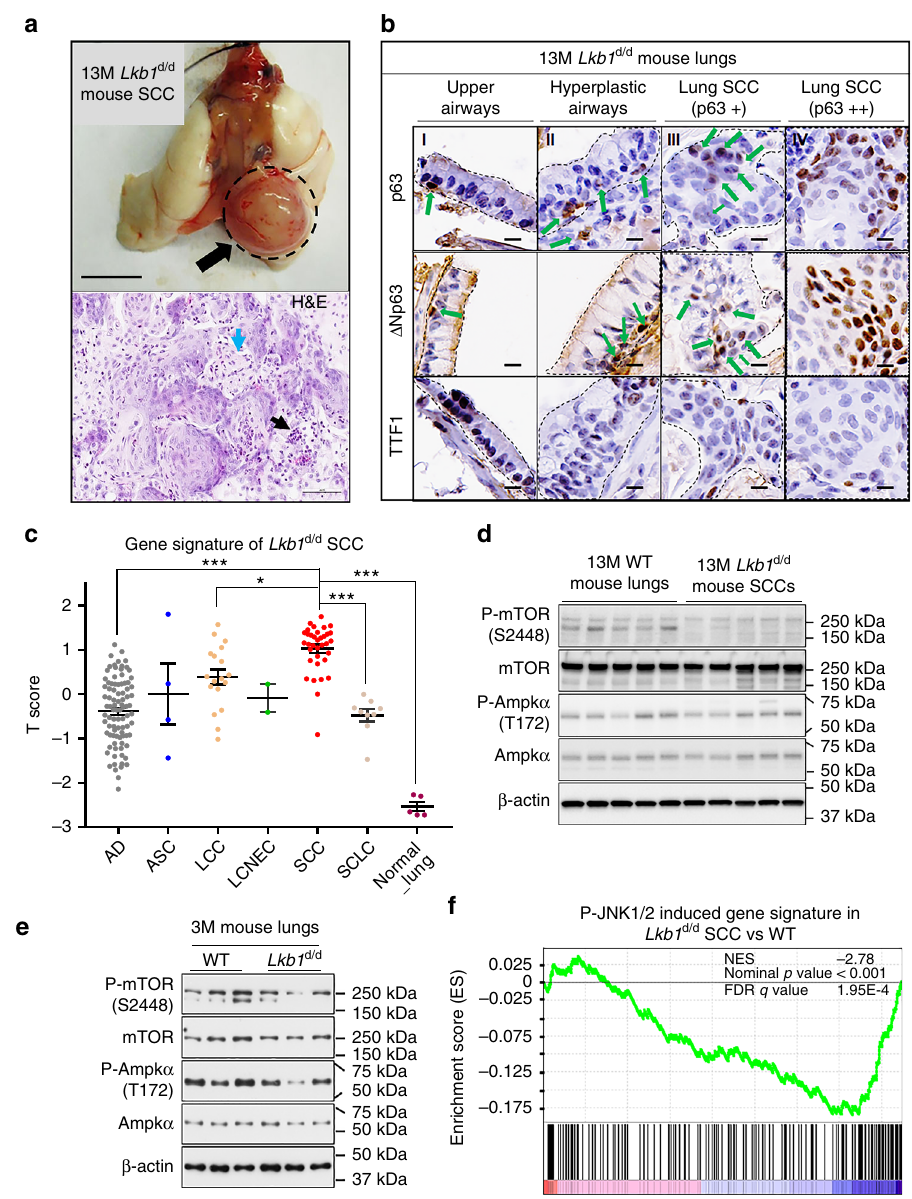
Fig. 1 Lkb1 ablation alone induces LSCC development with negative JNK1/2 activities. a Upper panel: Gross appearance of lung tumors in 13-month-old (13M) CCSP iCre Lkb1 f/f ( Lkb1 d/d ) mice. SCC squamous cell carcinoma; SCC was labeled by a dash cycle and an arrow (upper panel). Scale bar: 0.5 cm. Lower panel: Representative 13M Lkb1 d/d mouse lung SCC (H&E). In fi ltrates of neutrophils were commonly associated with SCC nests (black arrow, lower panel). Keratinization was frequently present in SCCs (blue arrow, lower panel). Scale bar: 60 μ m. b Representative immunohistochemistry (IHC) staining of 13M Lkb1 d/d mouse lung SCC. SCC markers: p63 and Δ Np63; AD marker: TTF1. “ + ” means the expression is mild or moderate, and “ ++ ” means the expression is strong. Dashes outline: Regions of interest. Positive staining is indicated in some panels by green arrows. Scale bar: 10 μ m. c Alignment of the gene signature of 13-month-old Lkb1 d/d mouse lung SCC tumors with Takeuchi human lung cancer database (GSE11969). A score greater than zero indicates a positive correlation with the murine gene signature of 13-month-old Lkb1 d/d mouse. AD adenocarcinoma, ASC adenosquamous carcinoma, LCC large-cell carcinoma, LCNEC large-cell neuroendocrine carcinoma, SCC squamous cell carcinoma, SCLC small cell lung cancer. ANOVA (Tukey − Kramer Multiple Comparisons (TKMC) Test) was performed and error bar is SEM; * P < 0.05; *** P < 0.001. d Western blot (WB) analysis ( n = 5) of protein expression in 13-month-old (13M) mice. e WB analysis ( n = 3) of protein expression in 3-month-old (3M) mice. f Gene set enrichment analysis (GSEA) of pre-ranked genes detected in microarrays analysis of 13-month-old Lkb1 d/d mouse lung SCCs. All detected genes (Supplementary Data 3) were ranked based on their fold changes ( Lkb1 d/d SCC vs. WT) from high (the left terminal of X -axis) to low (the right terminal of X